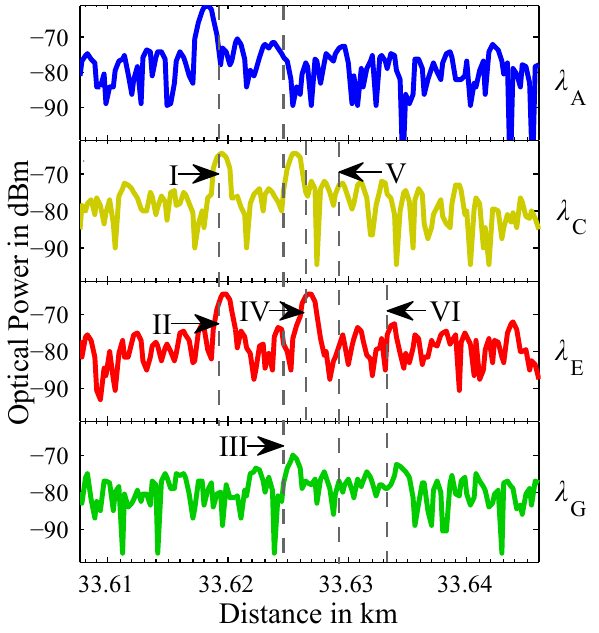
Figure 4. Result of conventional single impulse OTDR